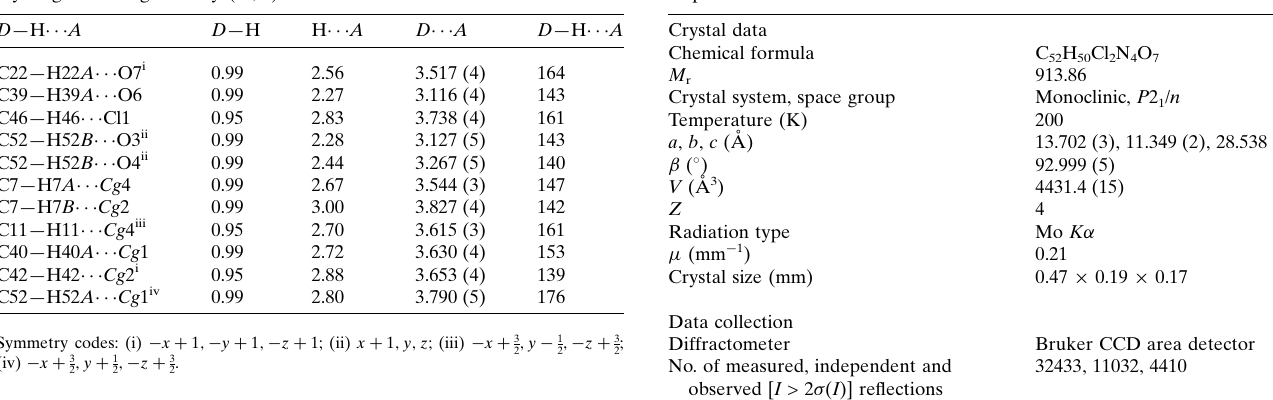
Table 1 Hydrogen-bond geometry (A˚ , (cid:4) ).